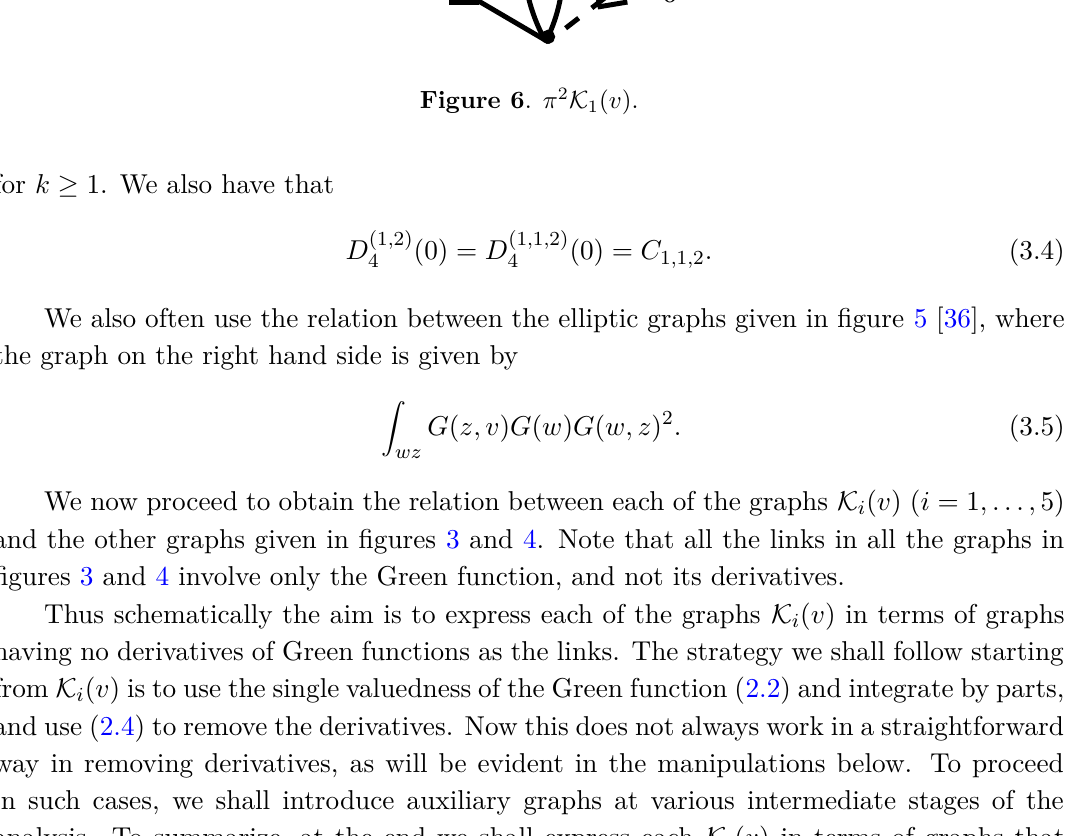
Figure 6 . π 2 K 1 ( v )